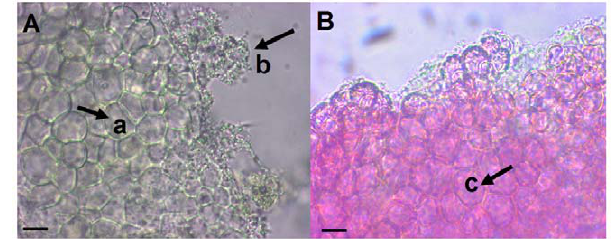
Figure 3. Bleaching of Deliseapulchra by strain LSS9. Algae were grown in artificial seawater without bromine and incubated at 25 u C with 10 6 cells/ml of strain LSS9 ( A ) and without bacteria ( B ). Bleached (pigment-free) algal cells (arrow a) and biofilms (arrow b) formed by strain LSS9 and are indicated by black arrows in ( A ). Healthy, red- pigmented algal cells (arrow c) are visible in the control algae ( B ). Scale bar = 10 m m.